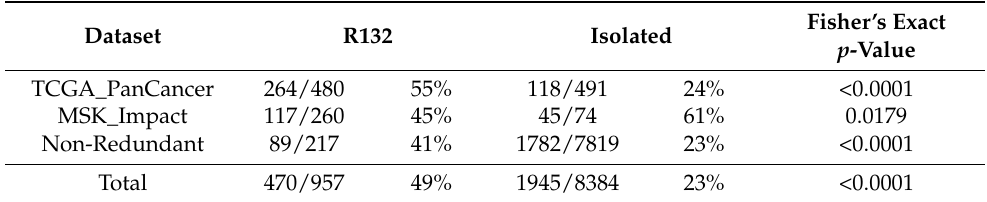
Table 3. Co-occurrence frequencies of TP53 alteration and IDH1 hotspot mutation or isolated alteration in human cancer.